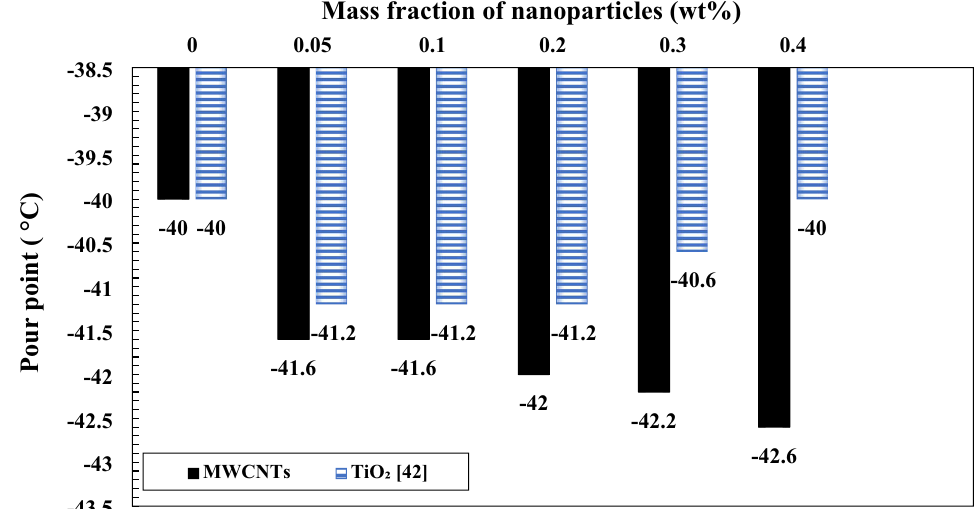
Figure 16. Comparison of pour point of TiO 2 /turbine meter oil and MWCNTs/turbine meter oil nanofluids in different mass fraction.